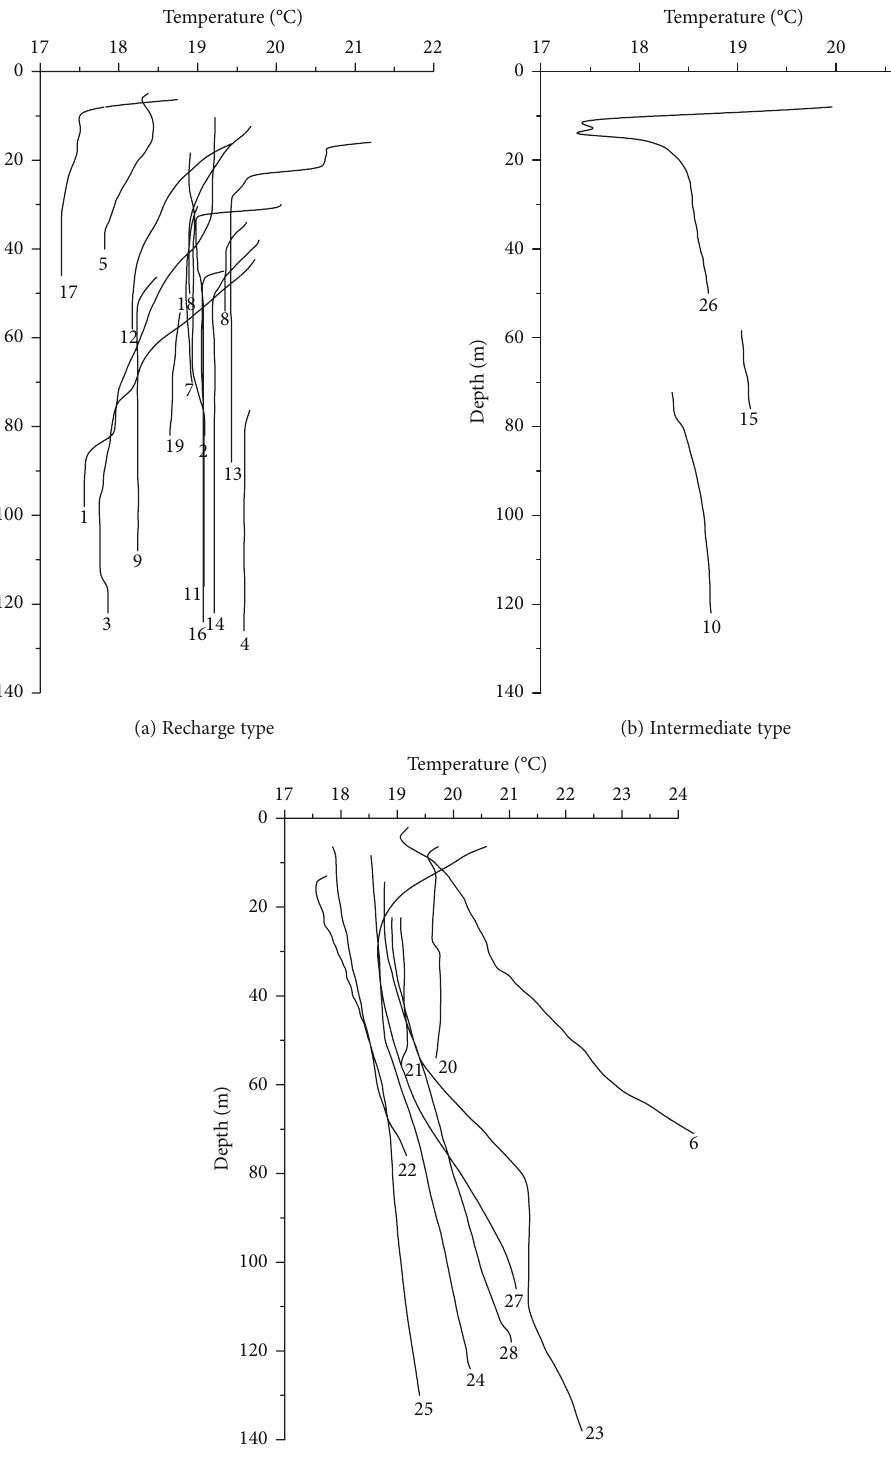
Figure 5: Classi fi cation of the observed temperature-depth pro fi les around 2012 (showing high similarity with the observed data around 2000 by Taniguchi et al.